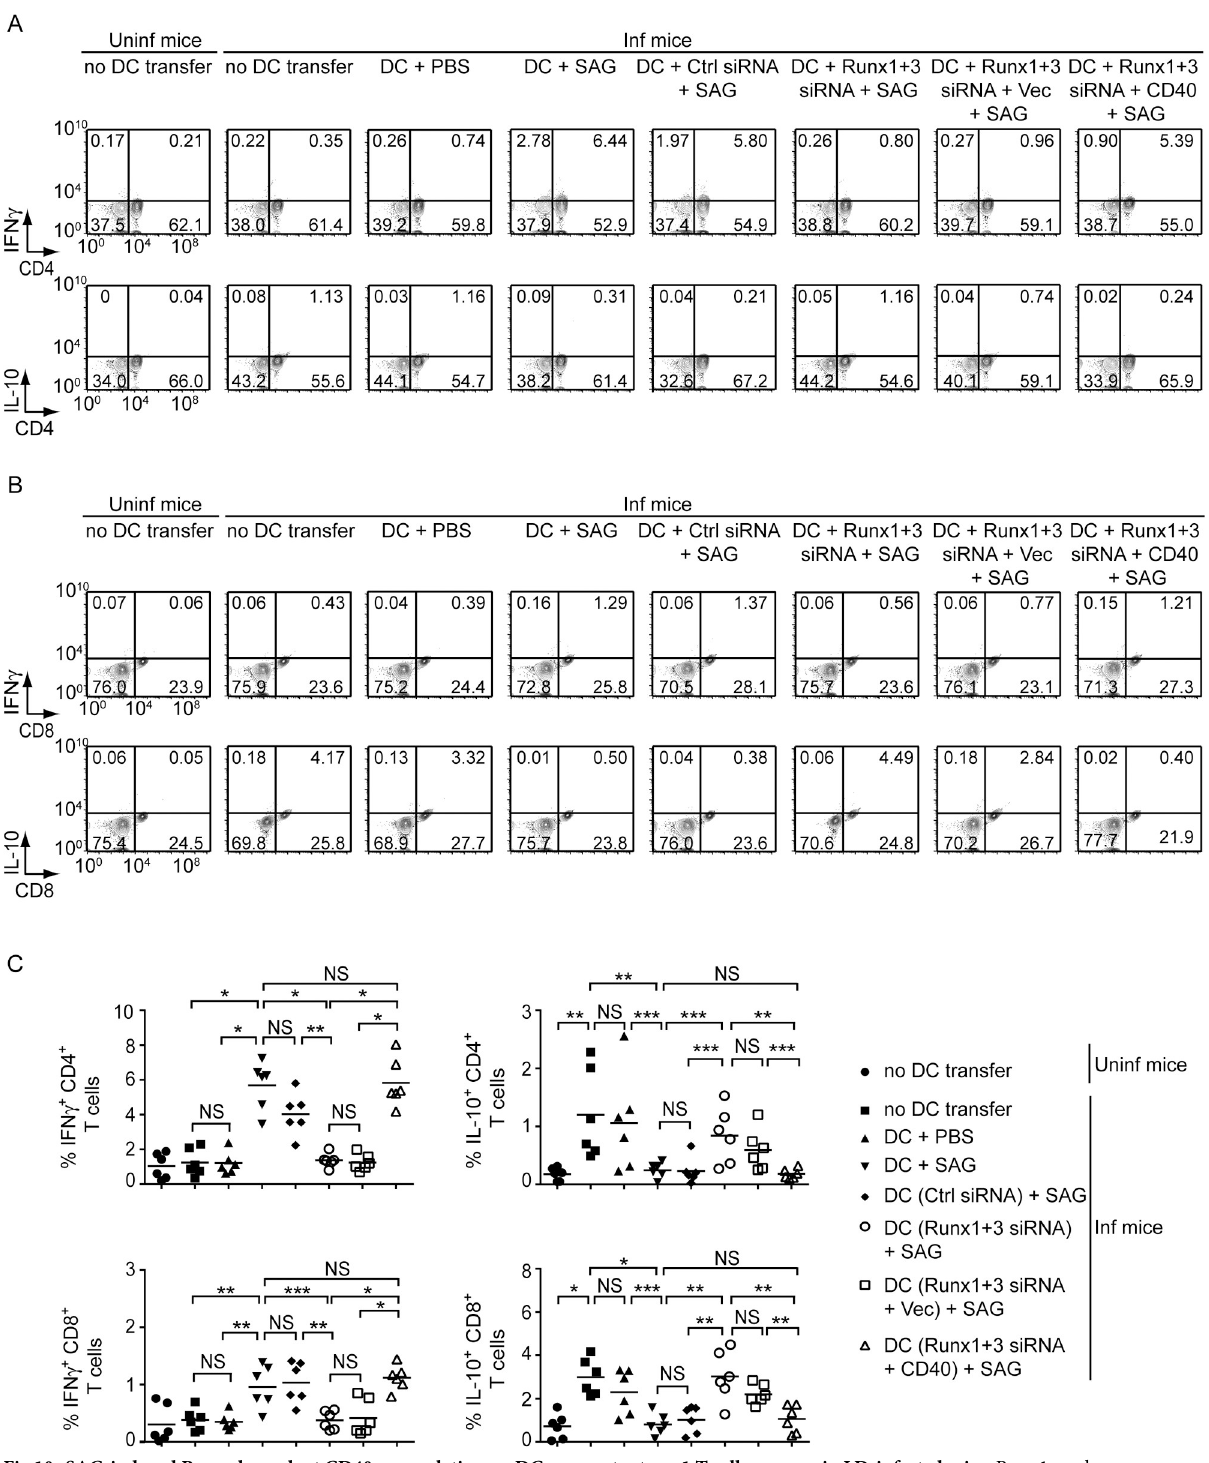
Fig 10. SAG-induced Runx-dependent CD40 upregulation on DCs promotes type-1 T cell response in LD-infected mice. Runx1- and Runx3-silenced BMDCs (with or without CD40 overexpression), and control-silenced BMDCs were treated with SAG and then adoptively transferred into LD-infected mice. Alternatively, age-matched uninfected and LD-infected mice were left without any DC transfer (details given in Fig 9 legend). (A and B) Frequency of IFN γ - and IL-10-producing CD4 + (A) or CD8 + (B) T cells in splenocytes isolated from these mice, assessed by flow cytometry (representative data of n = 6). Numbers indicate the percentage of cells in the respective quadrants. Gating strategy used for flow cytometry analysis is